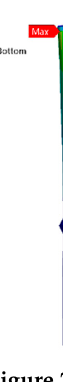
Figure 22. Hot spot under UIC (ice thickness was 0.32 m and ice velocity was 0.75 m·s − 1 ).